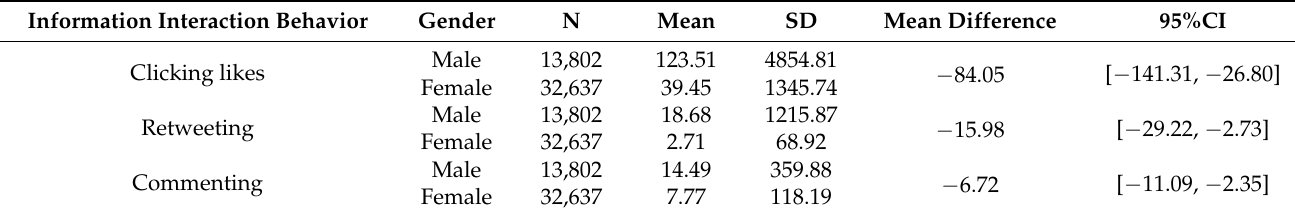
Table 2. Statistical differences in social media content engagement behaviors.